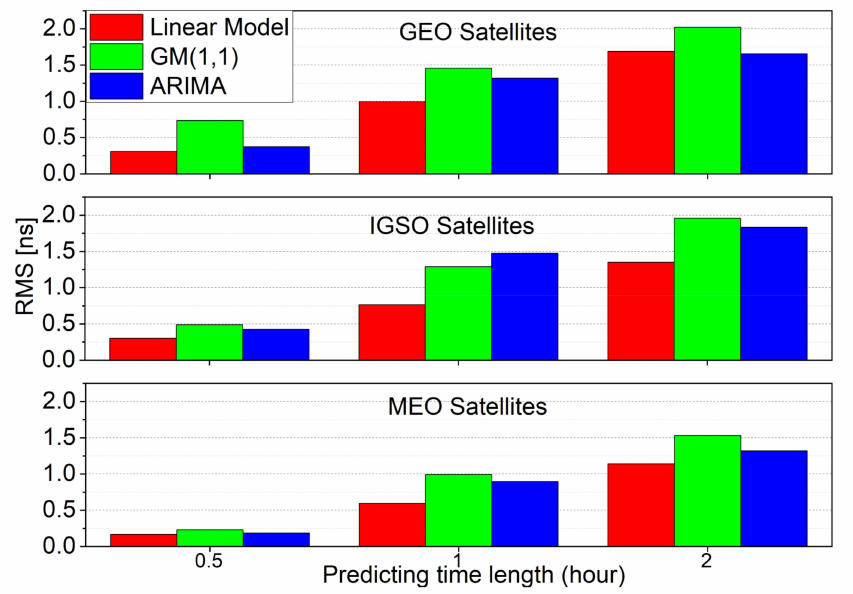
Figure 11. Average clock prediction accuracy for different prediction time lengths with the three models for different orbit